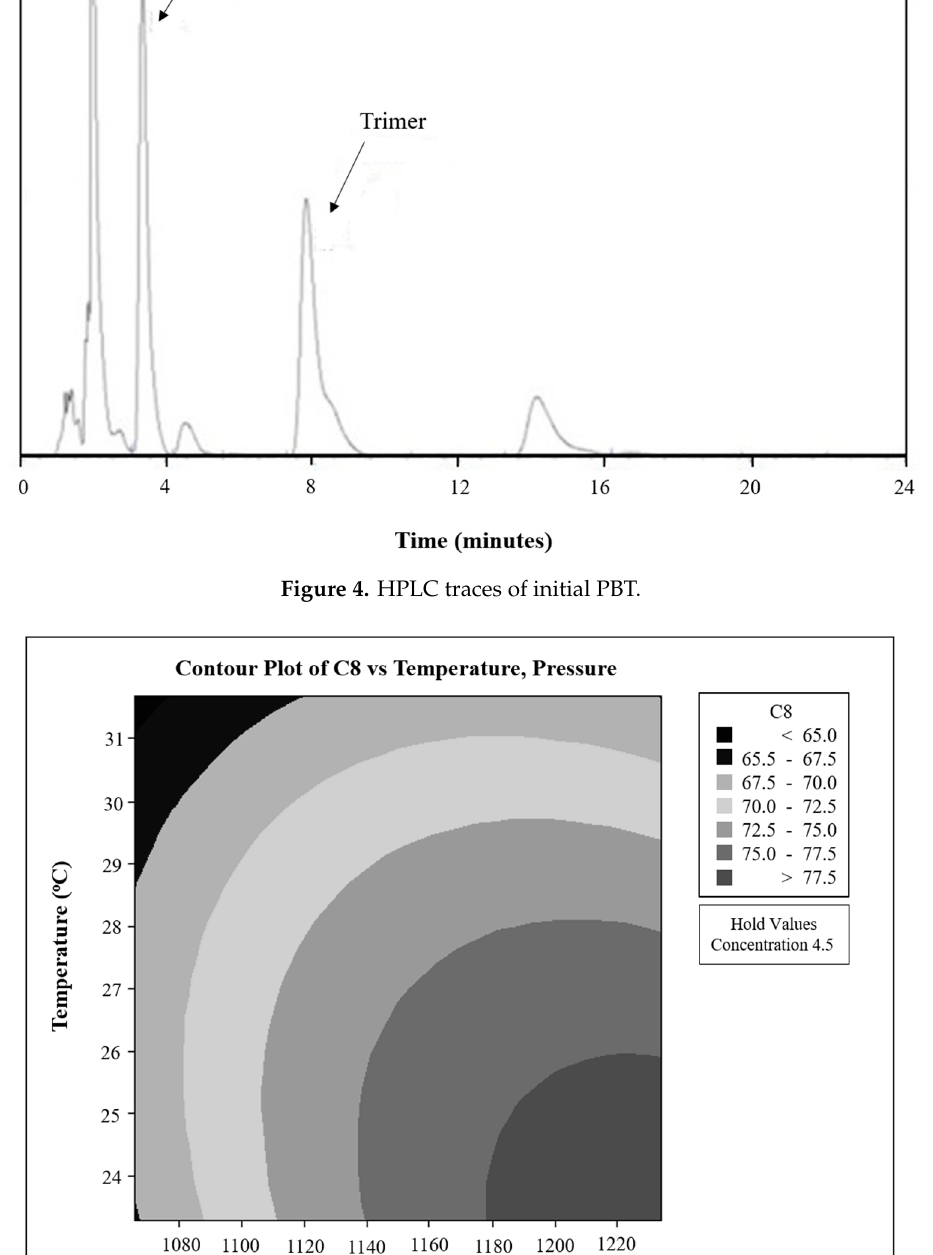
Figure 4. HPLC traces of initial PBT.